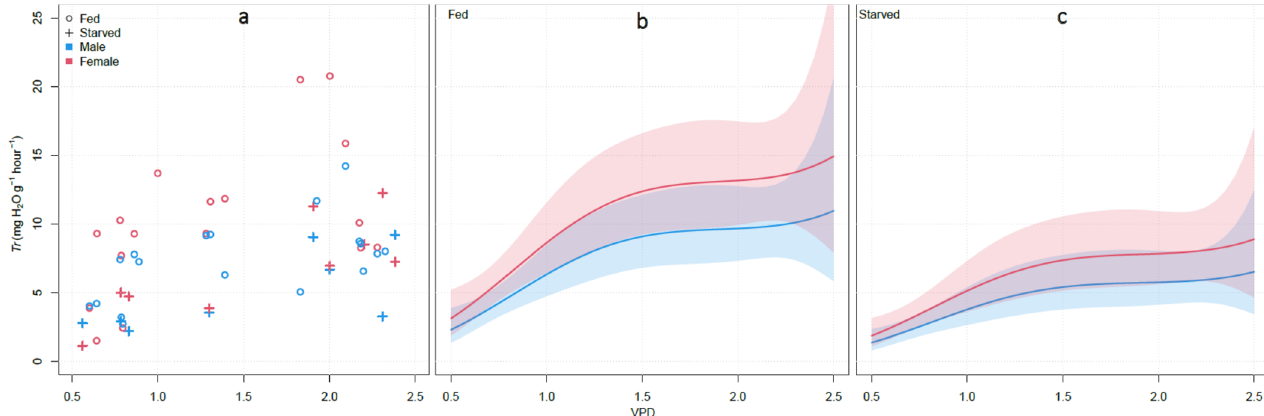
Figure 2. Linear mixed model of the changes in transpiration ( Tr ) of 54 adults at different VPD. ( a ) Scatterplot of the observations recorded and contrasts between males and females under fed ( b ) and starved conditions ( c ). In ( b , c ), the solid lines and the shaded areas represent the model prediction and the 95% confidence intervals, respectively.